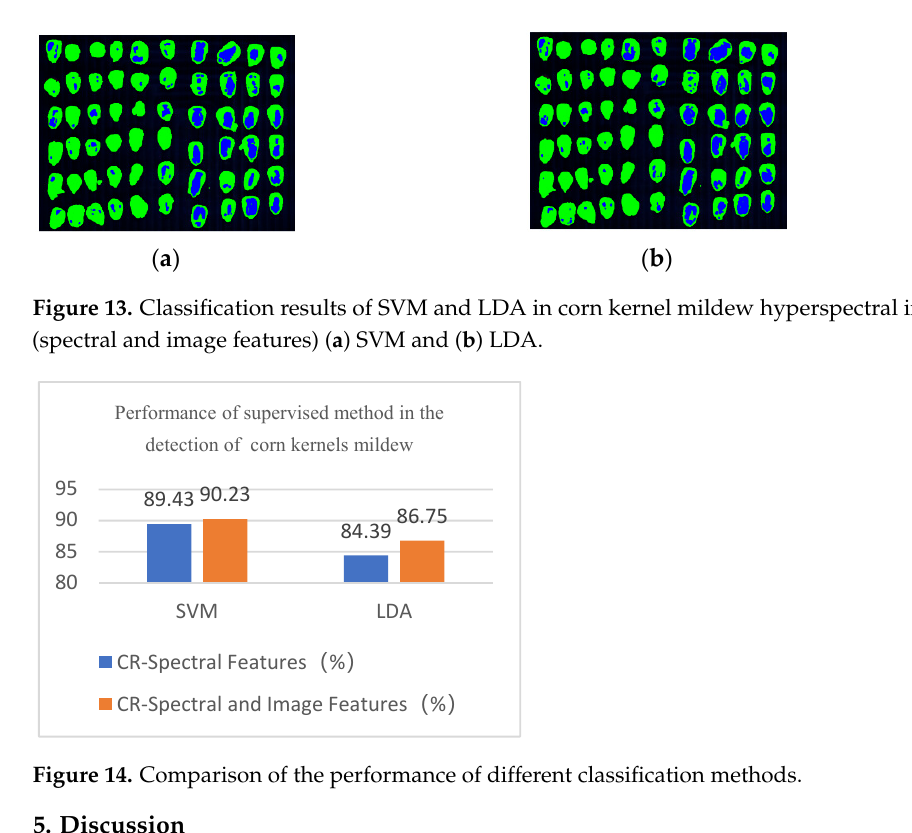
Figure 10. Clustering results in corn kernel mildew hyperspectral image data by different algorithms (spectral features). ( a ), Mildew corn kernels; ( b ), K ‐ means; ( c ), FCM; ( d ), KFCM; ( e ), GMM; ( f ), FCM ‐ SC.